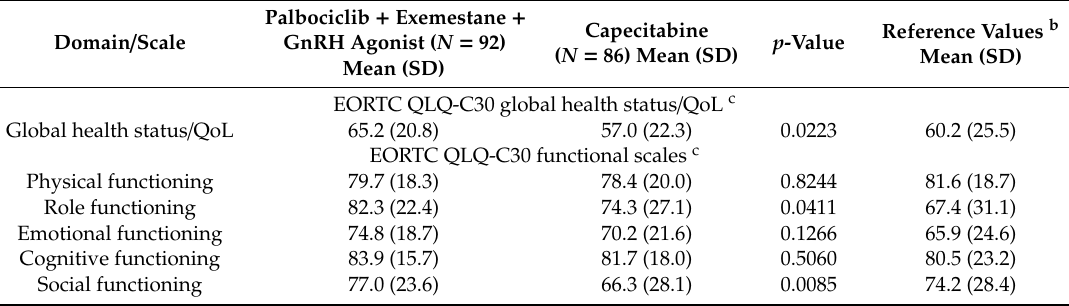
Table 1. Baseline EORTC QLQ-C30 scores and reference values (PRO analysis set a